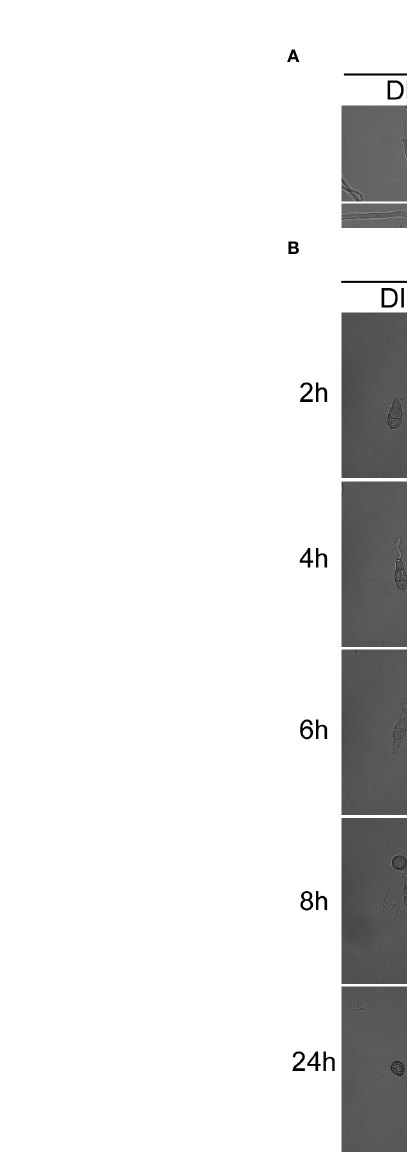
FIGURE 6 KC81 SUP impairs mitosis of M. oryzae . (A) Live cell imaging experiment to show MoH1-RFP (red fl uorescent protein) localization in M. oryzae mycelium in the presence or absence of KC81 SUP. (B) Live cell imaging experiment to show MoH1-RFP localization during M. oryzae appressorium development in the presence or absence of KC81 SUP. Bar = 10 m